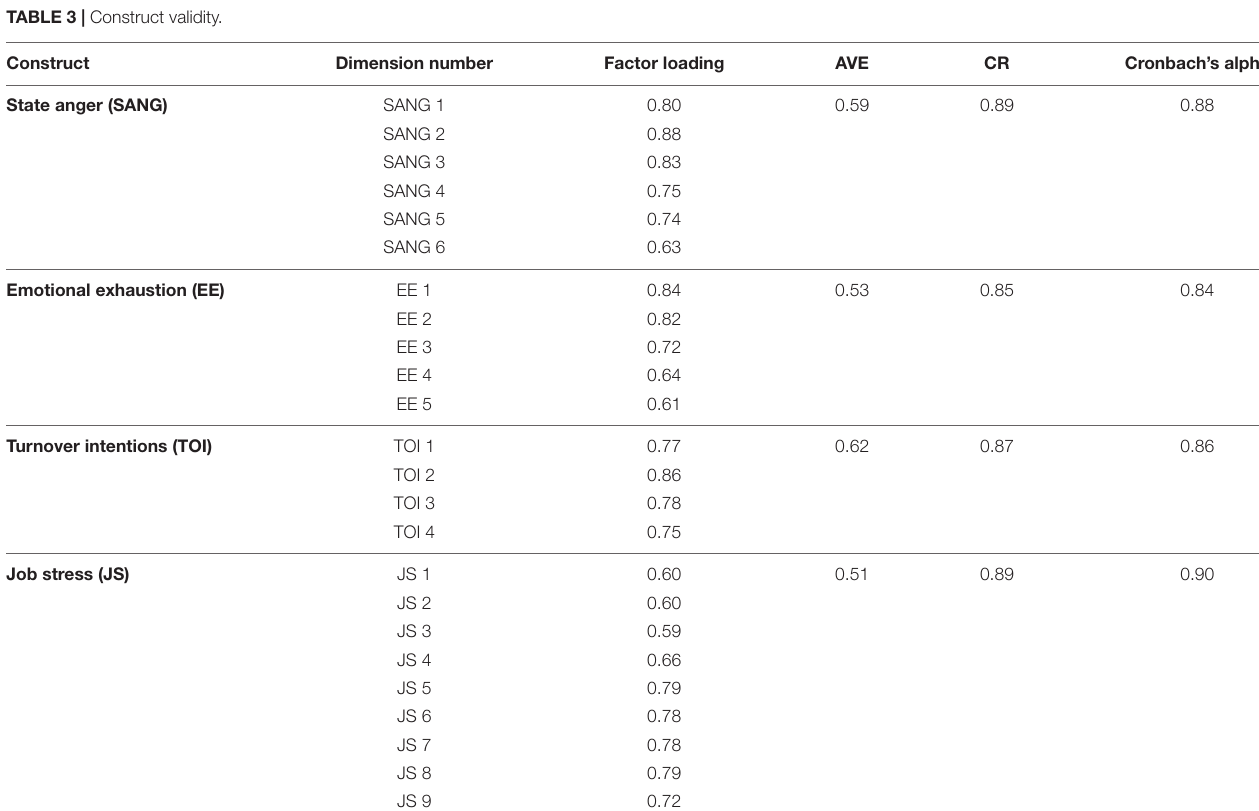
TABLE 3 | Construct